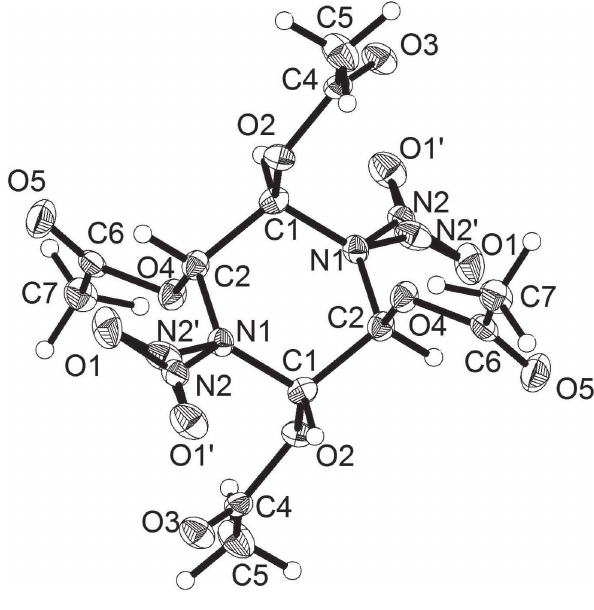
Table 1: Data collection and handling.